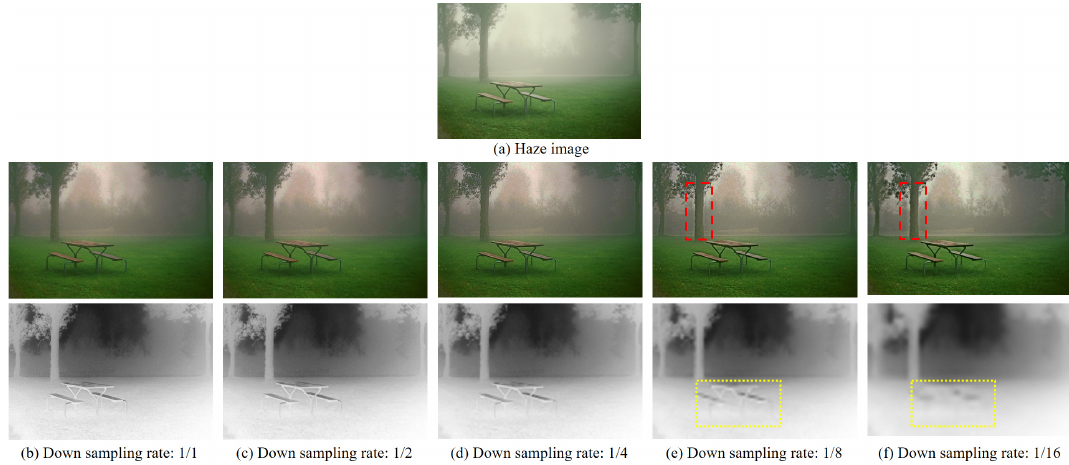
Figure 4. Haze image (first row), different haze-removal images (second row), transmission maps (third row) and corresponding down-sampling